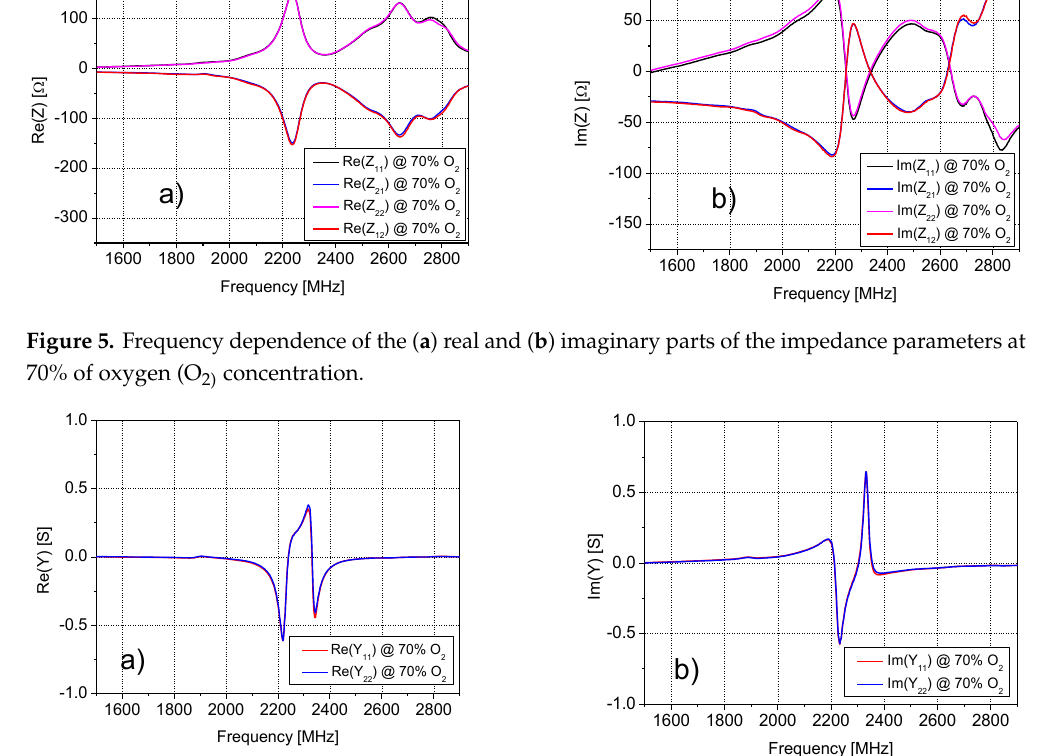
Figure 6. Frequency dependence of the ( a ) real and ( b ) imaginary parts of the admittance parameters Y 11 and Y 22 at 70% of O 2 concentration.